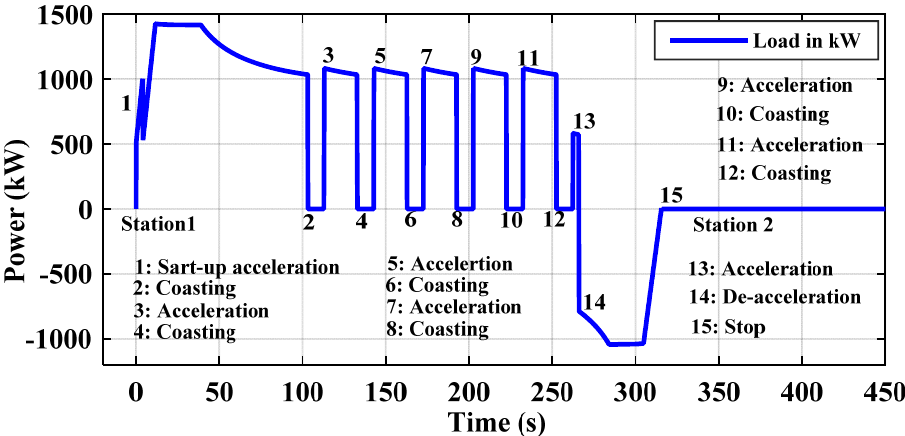
Figure 12. Train’s actual load profile between two stations (Emulated).